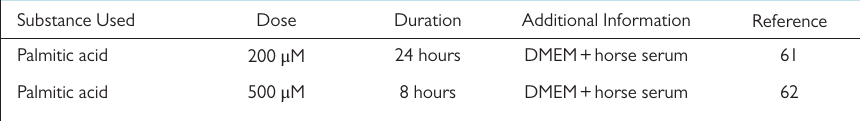
Table 5. Insulin Resistance Procedures in C2C12 Cell Lines